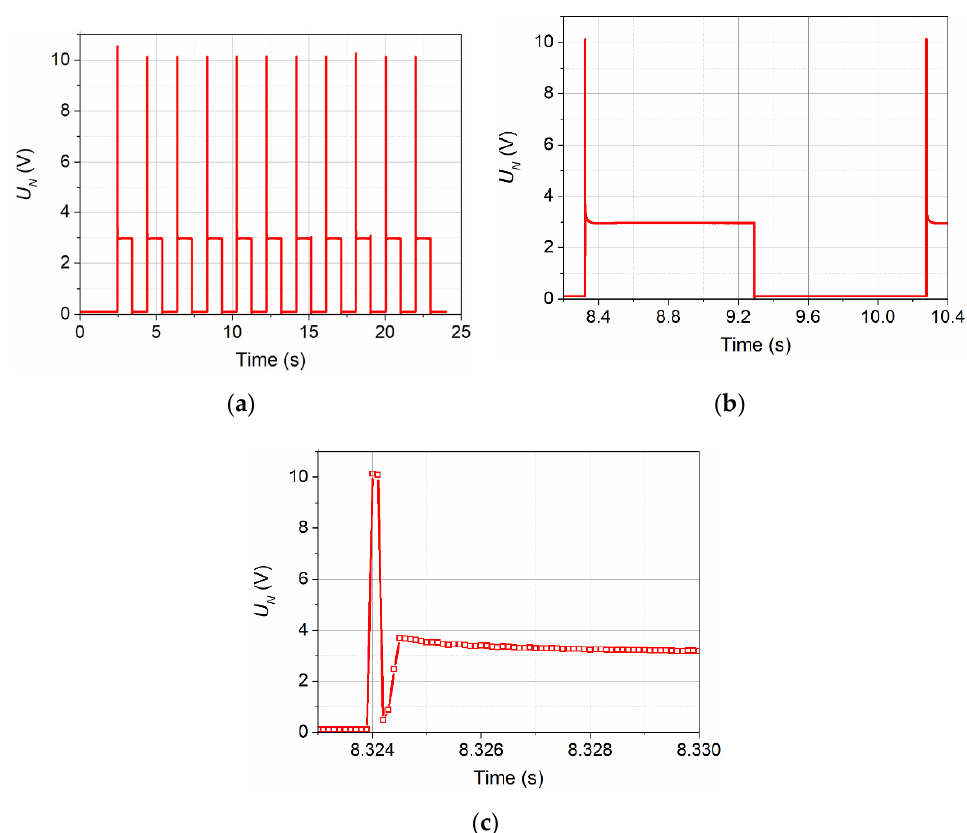
Figure 2. Voltage signal supplied to the transmitter by the CCC2002 device: course of 11 consecutive pulses ( a ), one selected pulse ( b ), and structure of the overdrive ( c ). The overdrive visible at the beginning of each pulse is to obtain the steepest possible edge of the signal heating the transmitter. The structure of this overdrive is shown in Figure 2c.